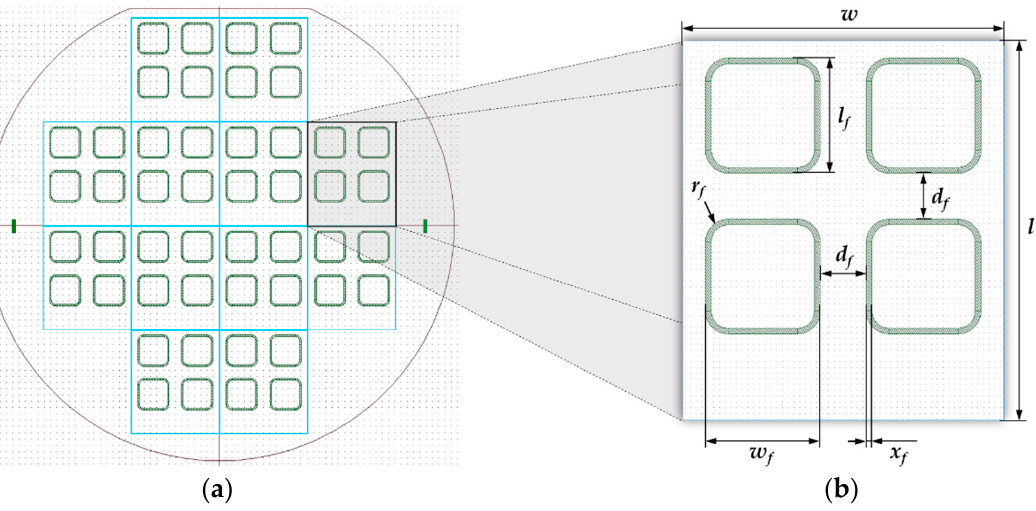
Figure 3. ( a ) Wafer design with twelve symmetrically arranged single chips; ( b ) Single chip with four bond frames.